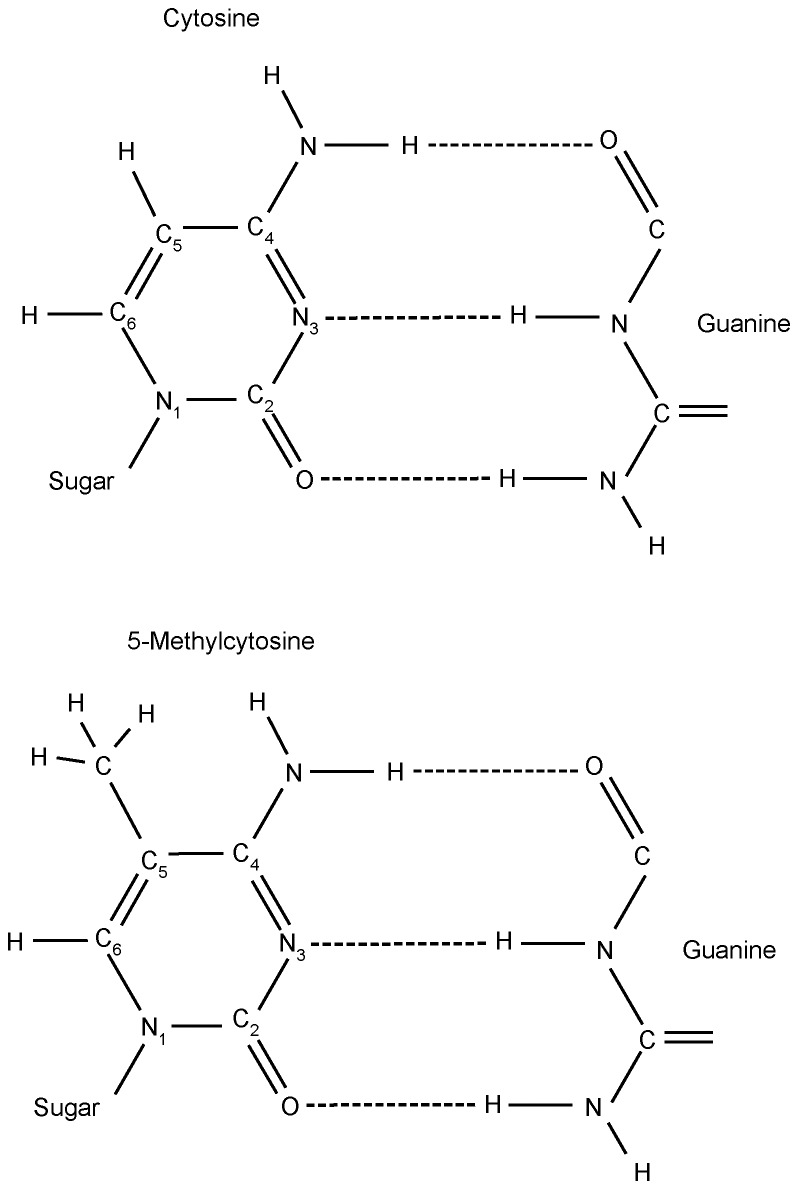
Molecular structure of cytosine (A) and 5-methylcytosine (B).